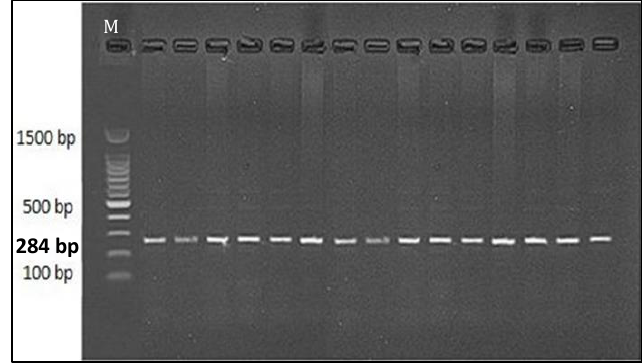
Figure 2. Electrophoresis of the PCR amplified TGF- β2 gene shows bands of approximately 284 bp in 1.5% agarose gel. M= 100 bp ladder